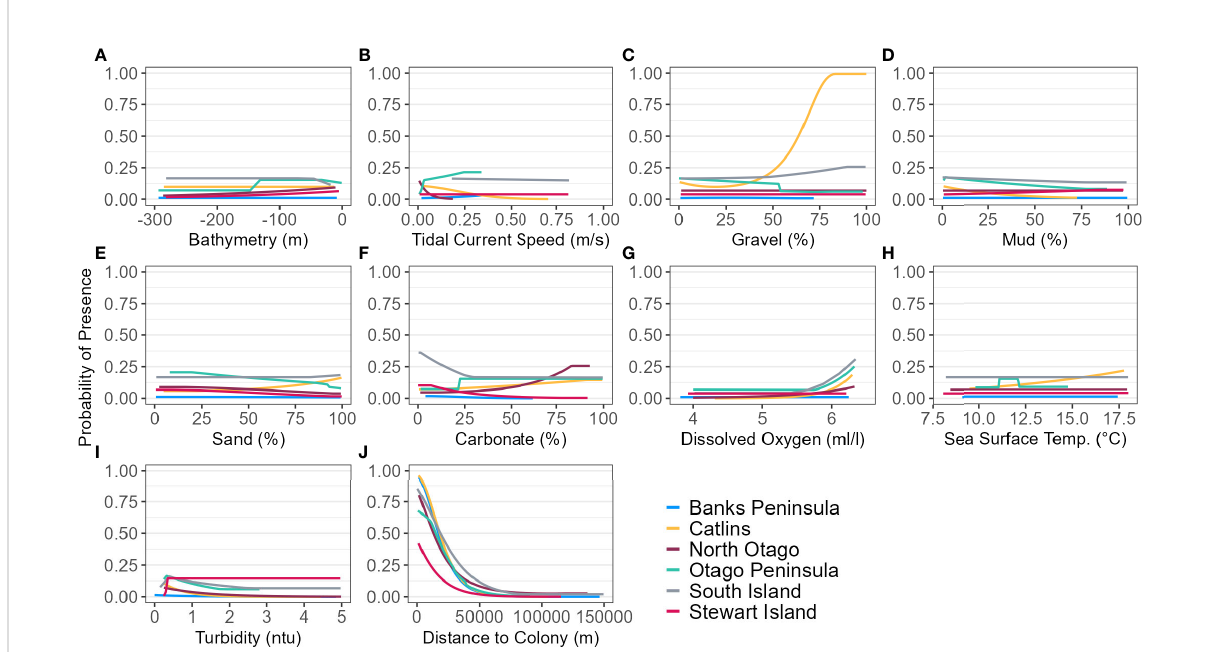
FIGURE 4 Response curves of each environmental predictor (A-J), including distance to colony, for each regional and South Island (SI) Maxent model predicting yellow-eyed penguin marine distribution.